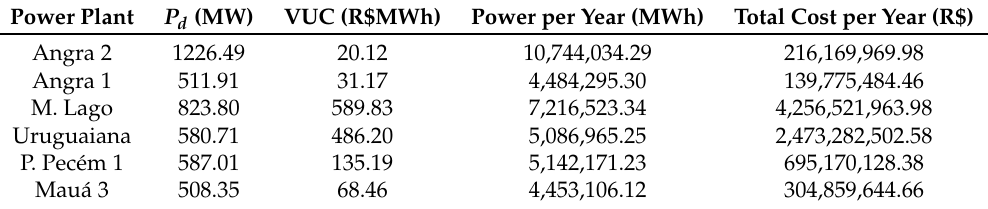
Table 8: Table 8. Estimated values of energy production by thermoelectric power plants. Power